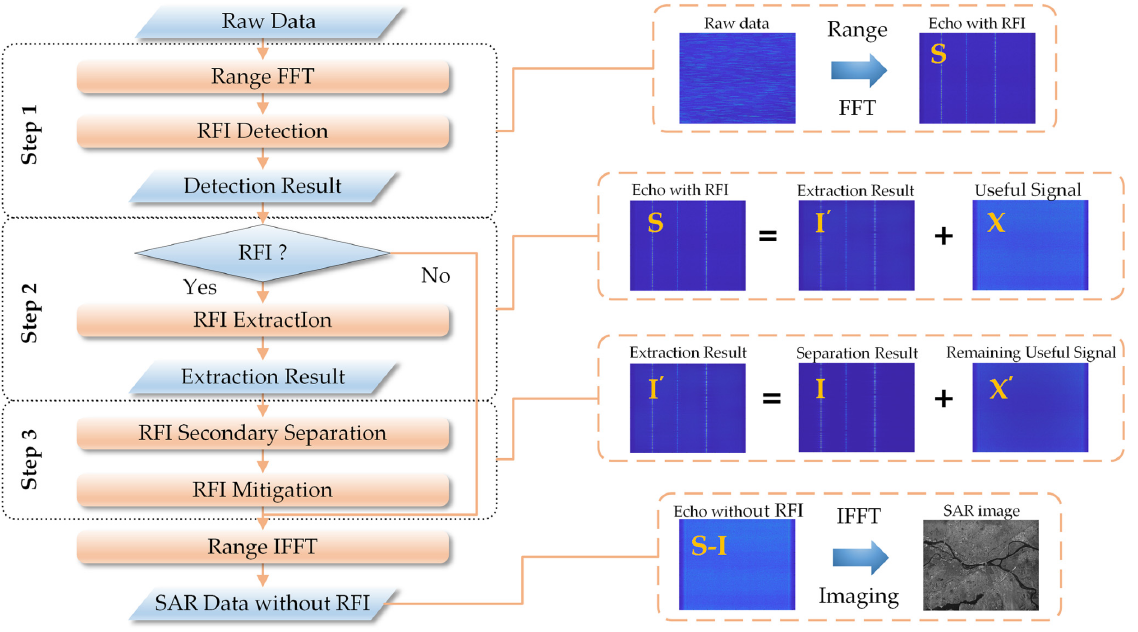
Figure 4. Flow chart of the proposed method.